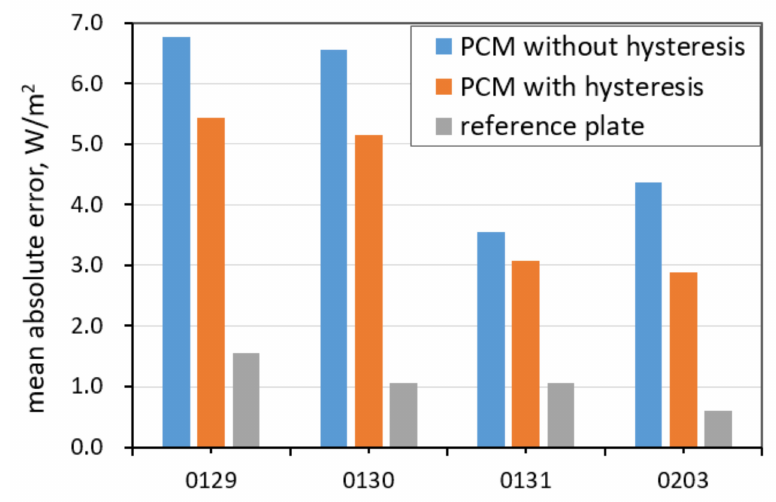
Figure 9. Mean error of surface temperature estimation in four cycles of